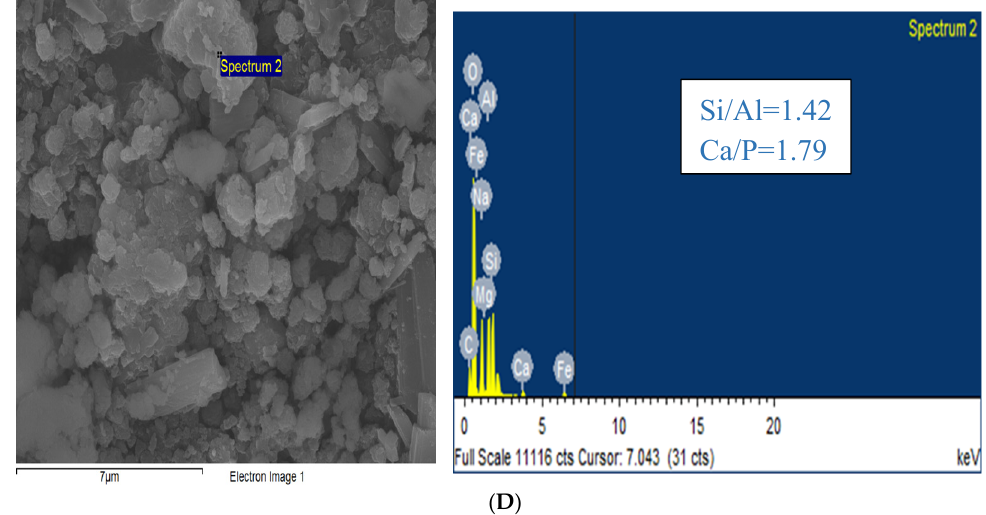
Figure 4. EDX spectroscopy of the HAP-ZE samples obtained at reaction temperature of ( A ) 80 °C; ( B ) 90 °C; ( C ) 100 °C and ( D ) 120 °C.